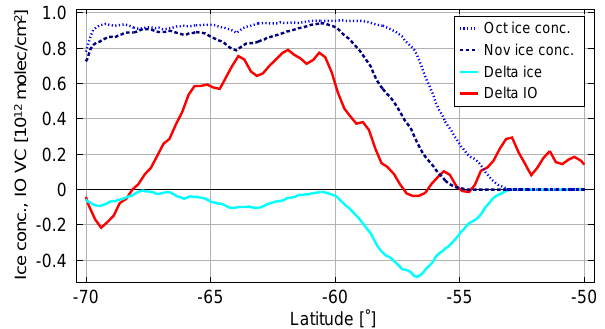
Fig. 9. Comparison of the change in ice cover with the change in IO abundance in the section from 0 ◦ –10 ◦ E versus latitude (marked area in Fig. 8). Blue dotted and dark blue dashed lines: the average ice concentration for October and November, respectively. The difference between the two curves is shown in solid light blue (November–October). The solid red curve displays the difference of the IO column amount between November and October.